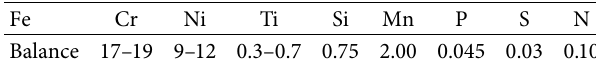
Table 1: Chemical composition (wt. %) of AISI SS type 321. Fe